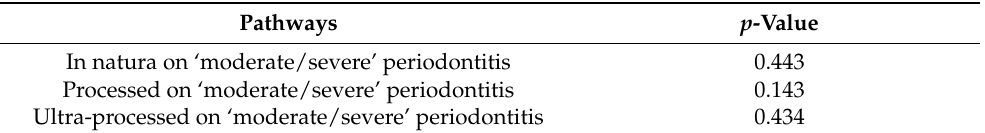
Table A3. Standardized effects of the interaction between ‘moderate/severe’ periodontitis and halitosis on food consumption among adults enrolled in the 1982 Pelotas birth